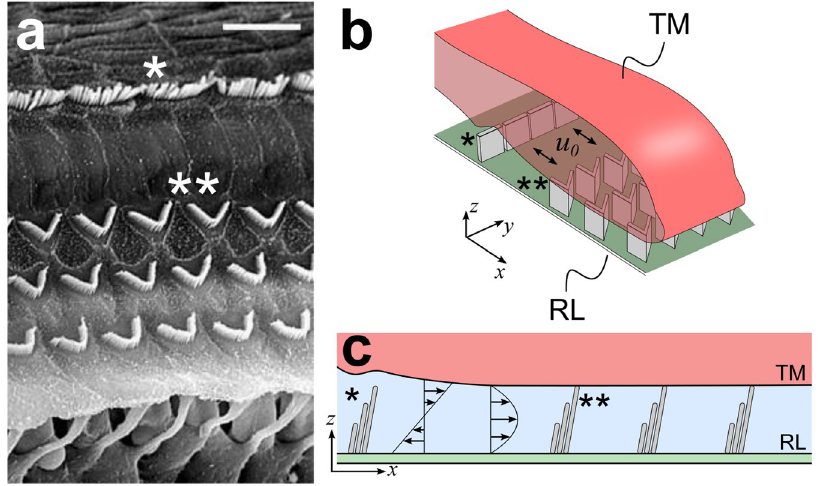
Figure 1. Anatomical environment of cochlear hair bundles. ( a ) Scanning electron microscopy shows hair bundles protruding from the reticular lamina 32 (scale bar 15 μ m, tectorial membrane removed). The hair bundles of inner hair cells are planar (asterisk) whereas those of outer hair cells have a characteristic V-shape (double asterisk). ( b ) Hair bundles of the outer hair cells connect the reticular lamina (RL) to the tectorial membrane (TM). Oscillatory fluid flow occurs in the radial direction, perpendicular to the rows of hair cells (double-sided arrow). ( c ) Fluid flow around hair bundles can include shear flow as well as net flow. The latter may arise from squeezing of the gap between the reticular lamina and the tectorial